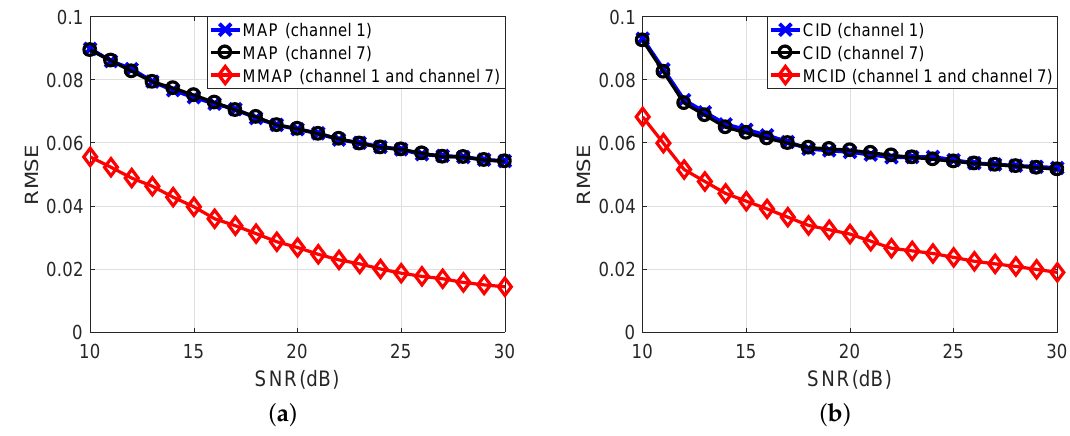
Figure 11. Average RMSE of different algorithms. ( a ) The RMSE of MAP and proposed MMAP; ( b ) The RMSE of CID and proposed